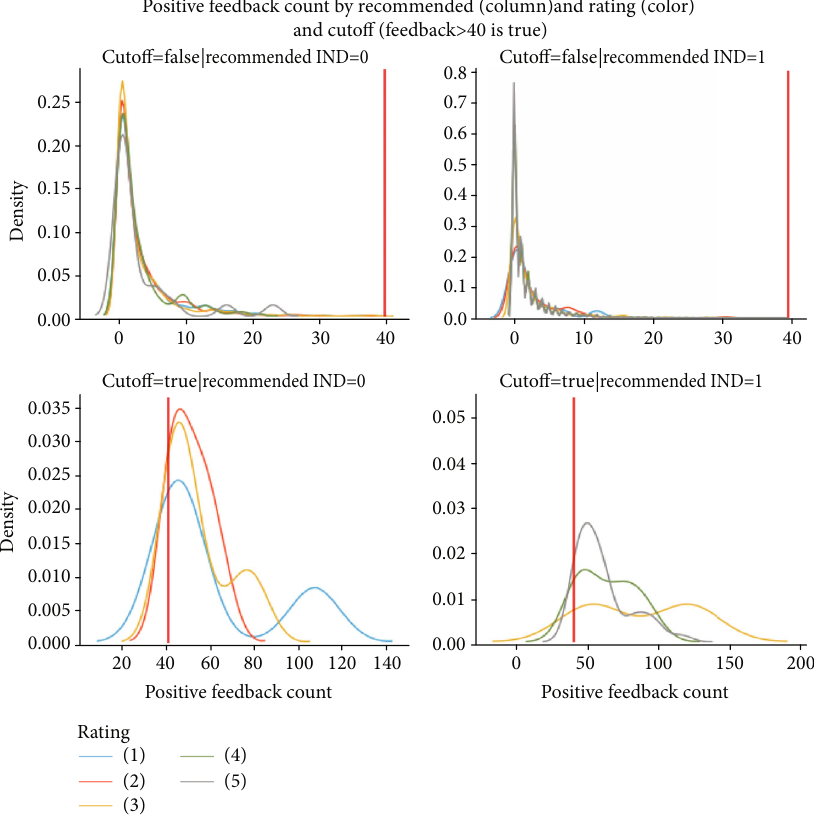
Figure 16: The positive opinion obtained by more than 40 reviews and ratings.